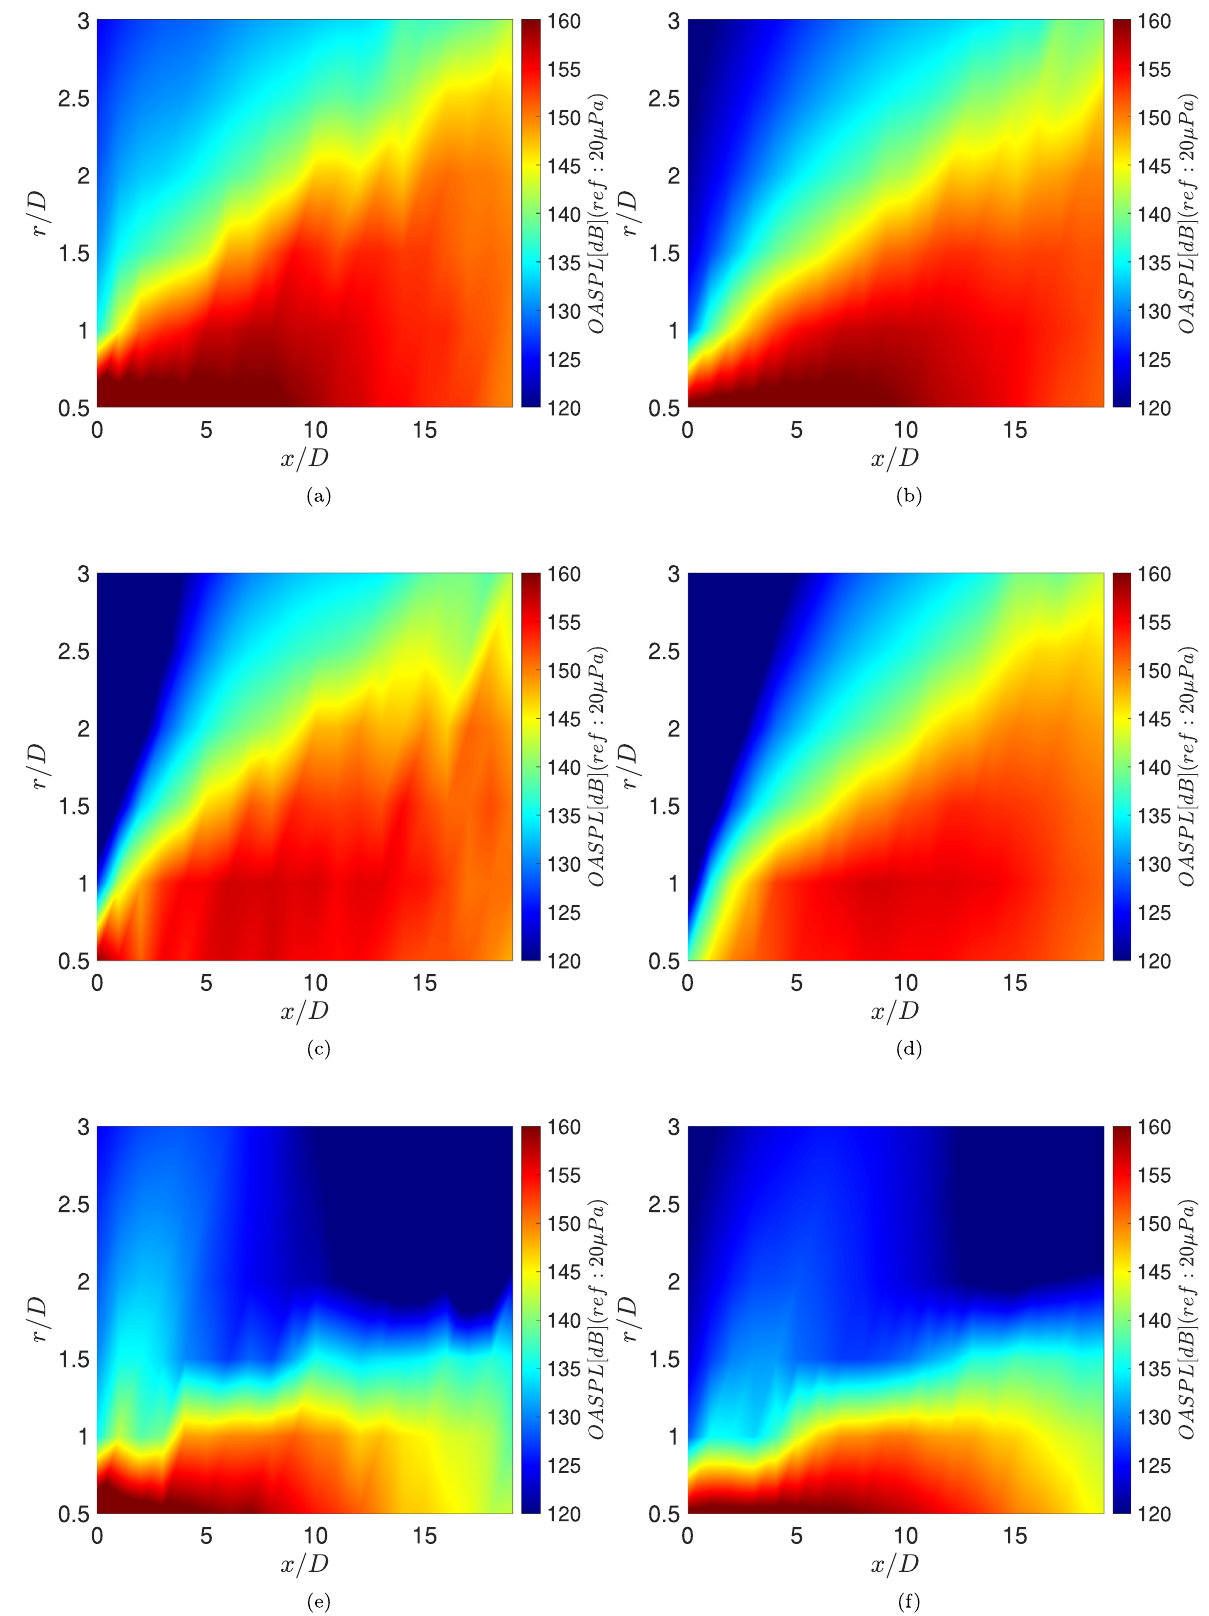
Figure 3. ASPL contour maps for TI = 3% (a, c, e) and TI = 9% (b, d, f): (a) and (b) original signals; (c) and (d) hydrodynamic components; (e) and (f) acoustic